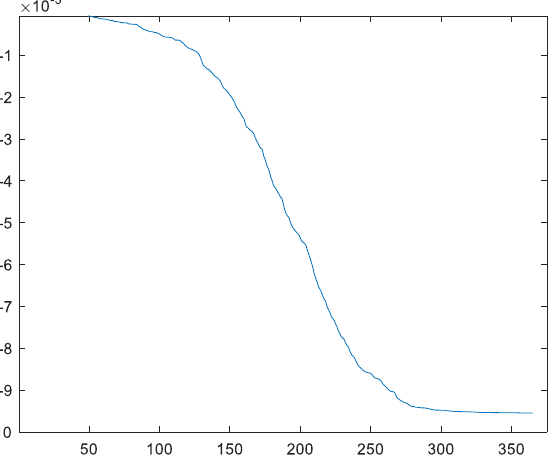
Figure 10. Offshore cumulative effect of environment on degradation over one year.